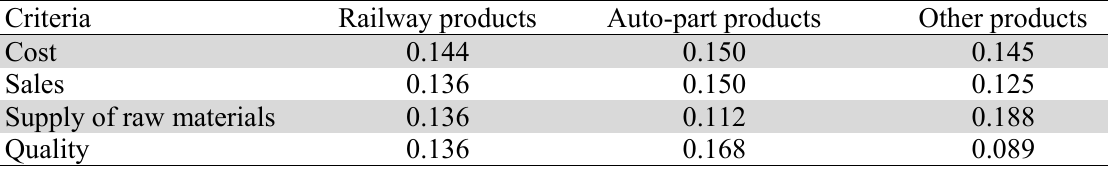
The results of pairwise comparison in section C